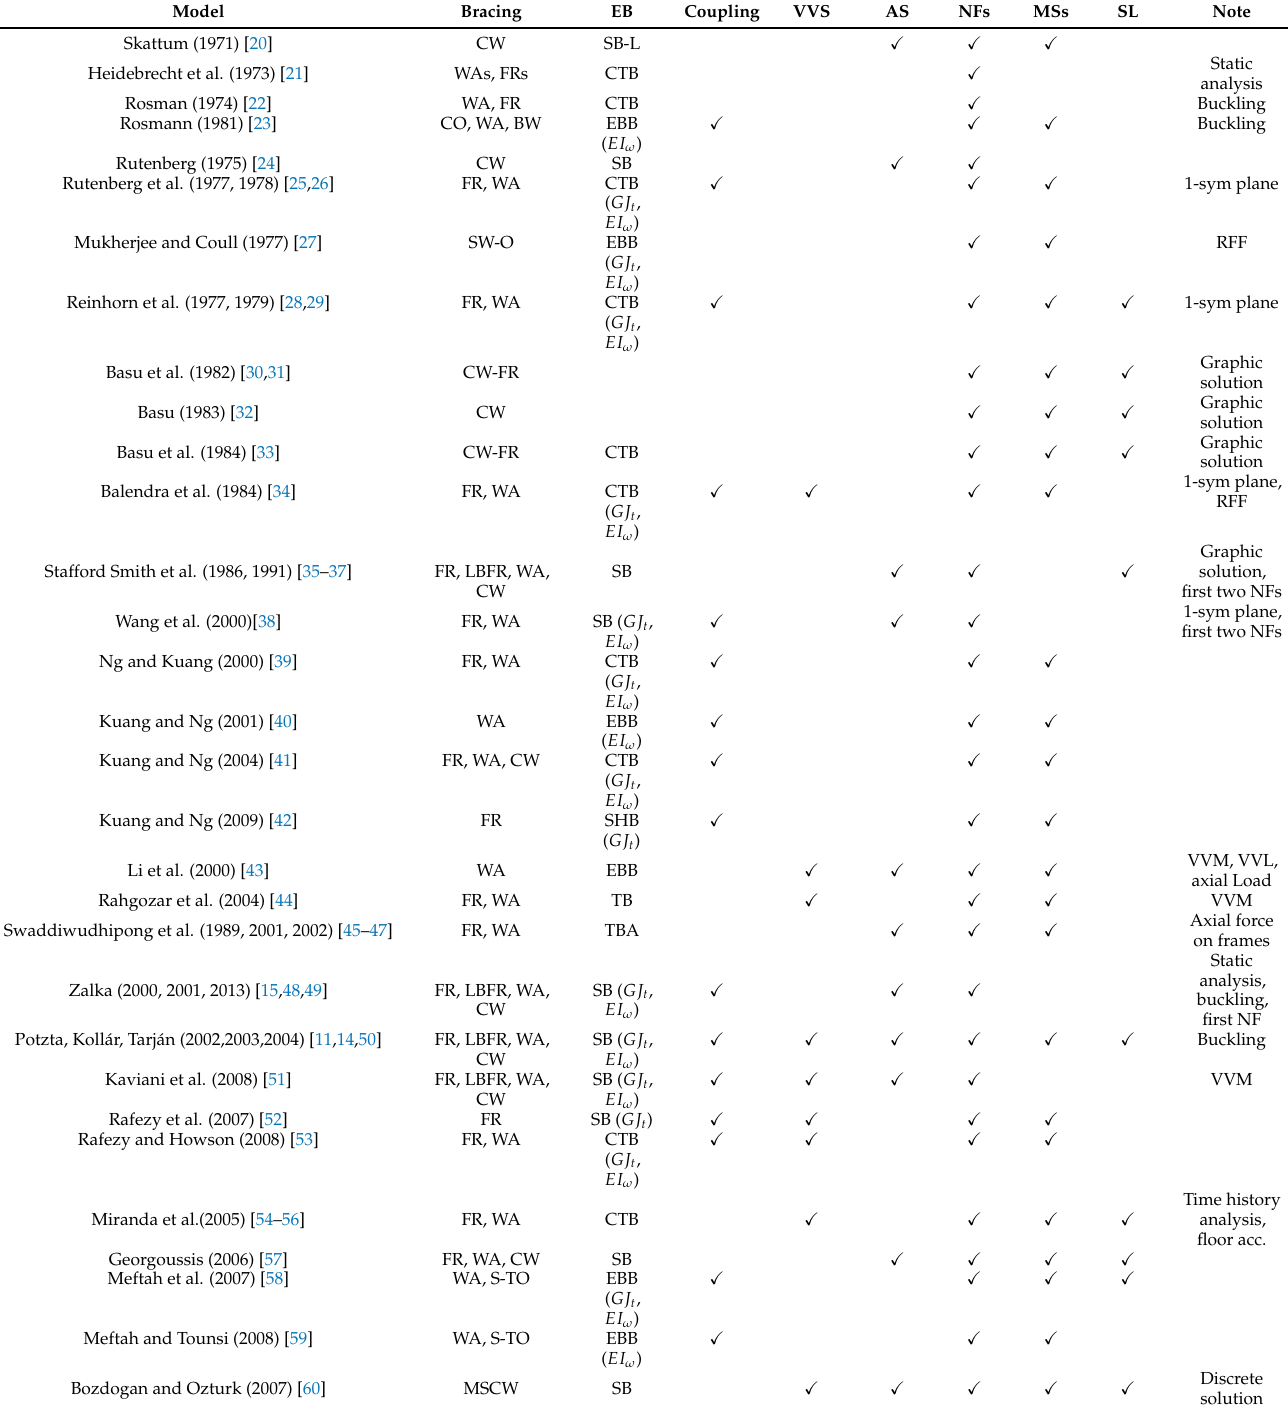
Table A1. Summary of the main equivalent beam models reported in the literature.